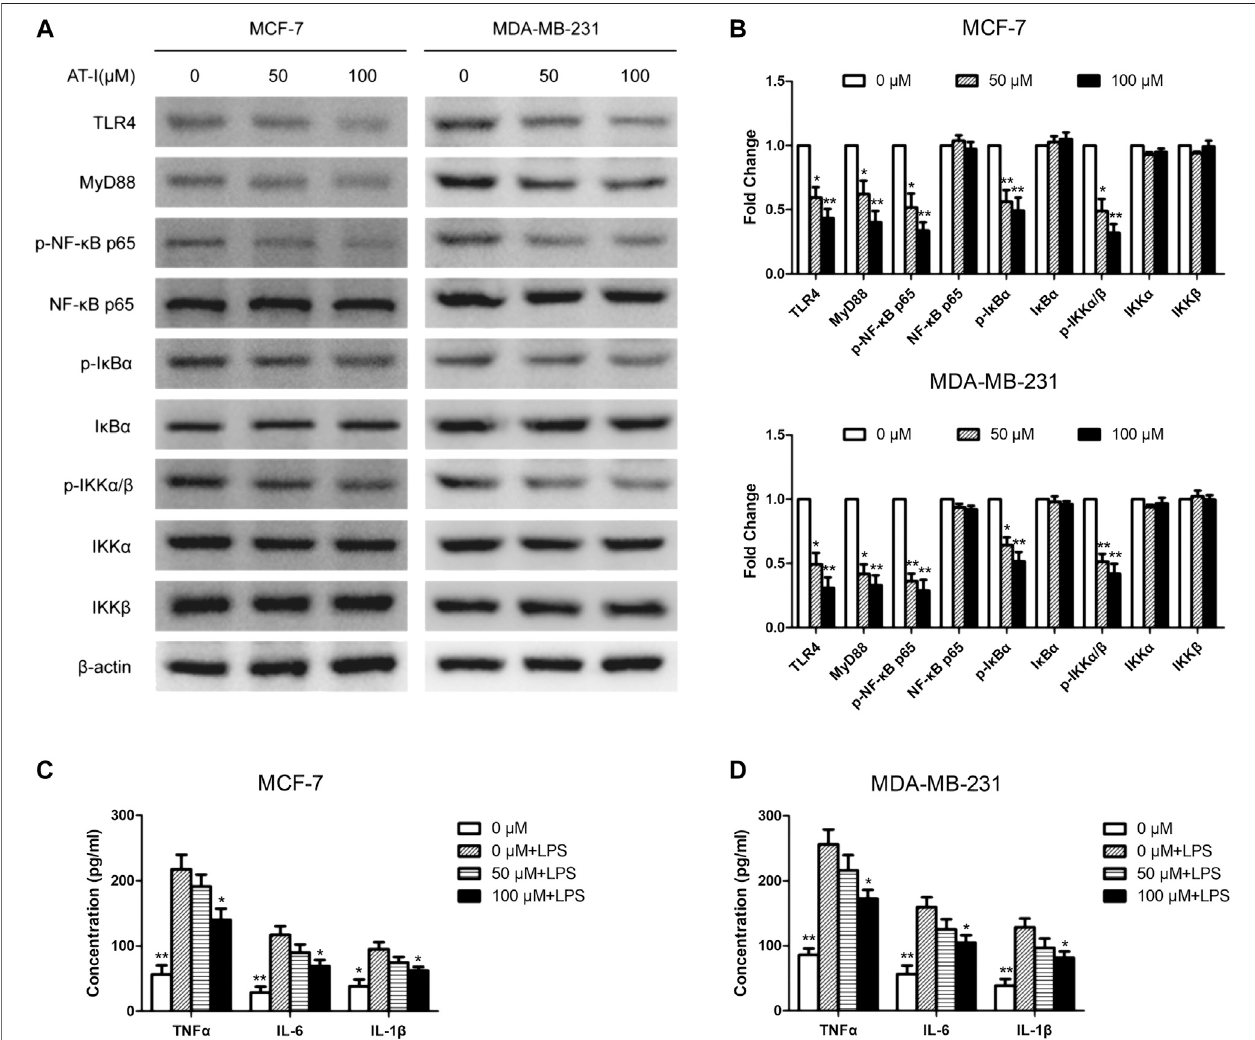
FIGURE 4 | AT-I regulated TLR4/NF- κ B signaling pathway in breast cancer cells. (A, B) The effects of AT-I on TLR4/NF- κ B signaling pathway were measured by western blot assay. (C, D) The levels of TNF- α , IL-6 and IL-1 β in the supernatants of cells were measured by ELISA assay. Signi fi cant differences between different groups were indicated as * p < 0.05, ** p < 0.01, vs. the 0 μ M control group or the LPS treated control group, n (cid:1)